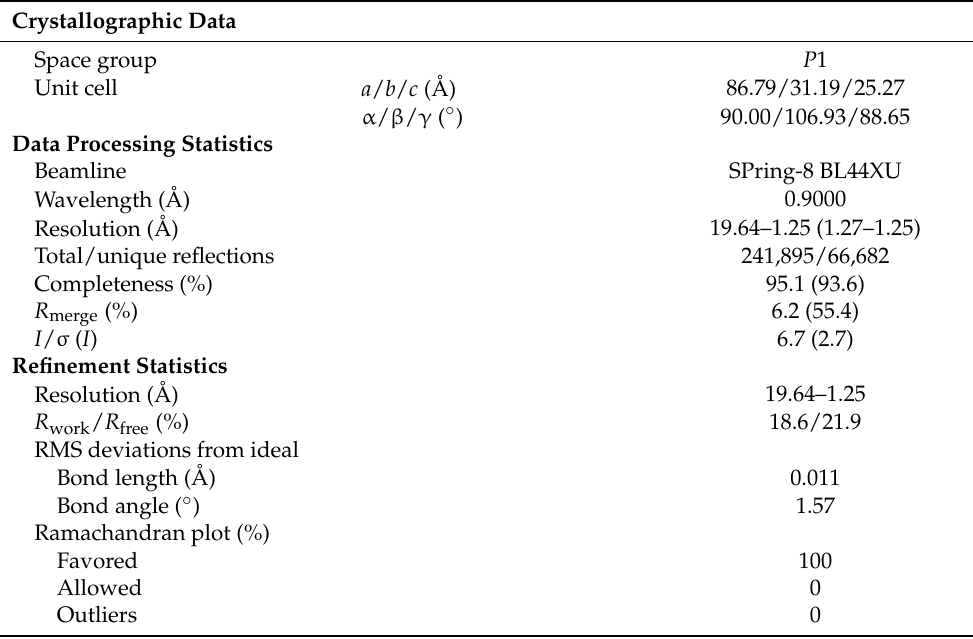
Table 2. Data collection and refinement statistics for the crystal structure of K48C-diUb. Crystallographic